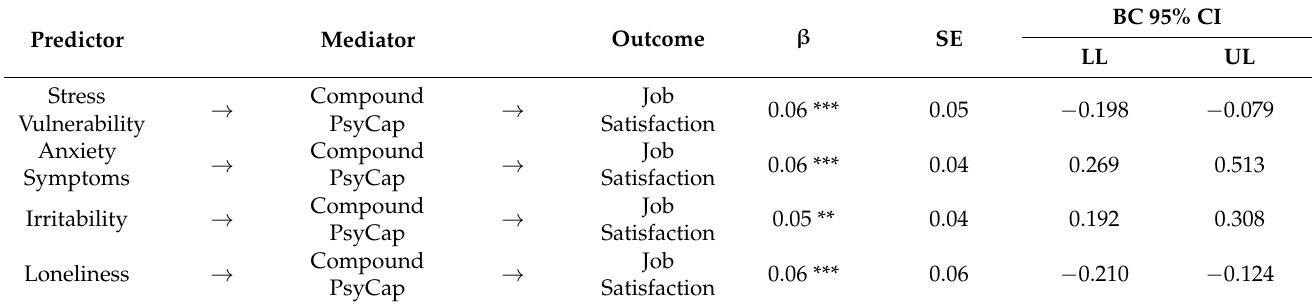
Table 3. Standardized indirect effects from Stress Vulnerability, Anxiety Symptoms, Irritability and